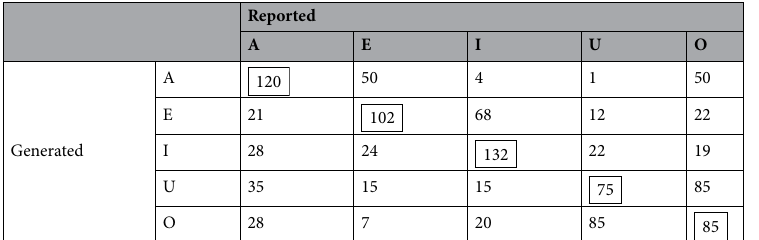
Table 1. Contingency table for vowel identification of all 1125 stimuli. Each row corresponds to a set of five synthetic vowels generated around a nominal value of the vowel parameter. Each column corresponds to one of the five possible reported